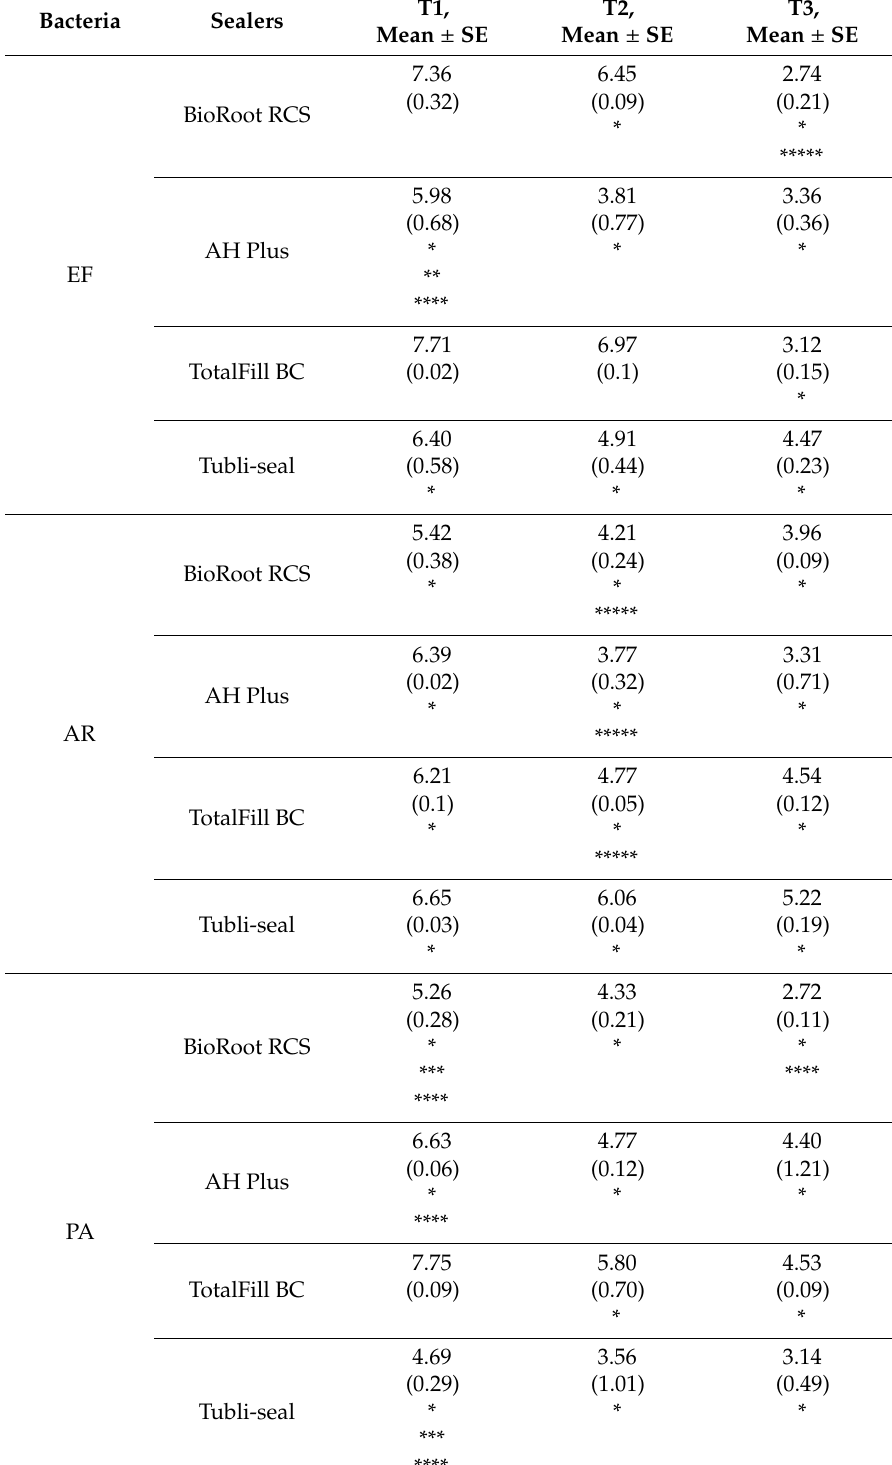
Table 3. Quantitative viable counts of E. faecalis (EF), A. radicidentis (AR), P. acnes (PA), S. epidermidis (SE) and S.mitis / oralis (Sm / o) following direct contact with each sealer at 1 h (T1), 24 h (T2) and 168 h (T3) comparing the e ff ectiveness between the sealer groups. The values are given as the mean number of bacteria ( ± standard error) as log10 (CFU per sample mL − 1